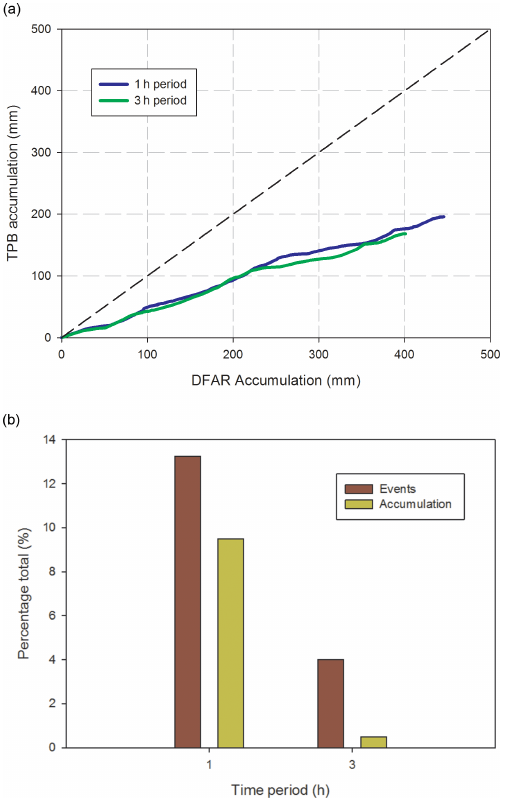
Figure 5. (a) Total accumulation reported by the TPB and DFAR and (b) percentage of events and accumulation during those events for which the catch ratio (TPB/DFAR) was greater than 1 for 1 and 3h time intervals.